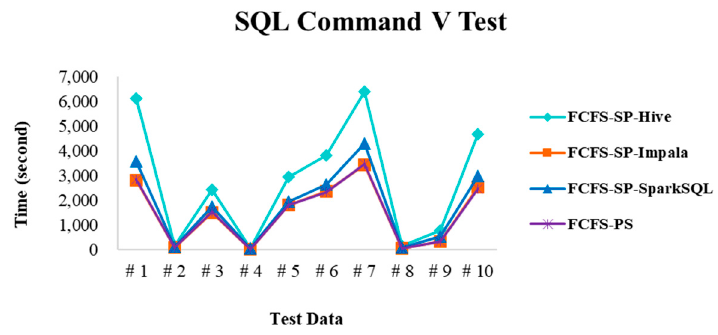
Figure 24. Execution time of SQL command V in test environment II.